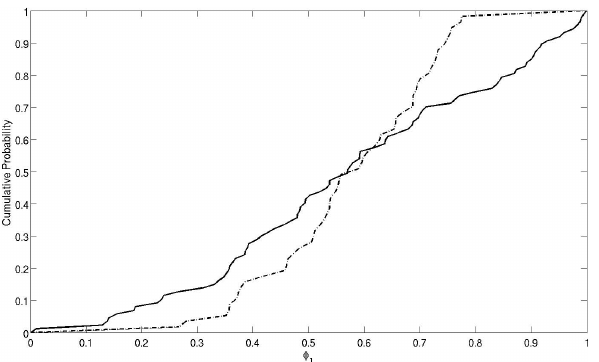
Fig. 6. Cumulative distribution of α 2 for behavioural parameter sets of the two situations considered: Analysis using the full data set with (κ min , κ max ) =( − 10, 0.98) (solid) and with the disinformative